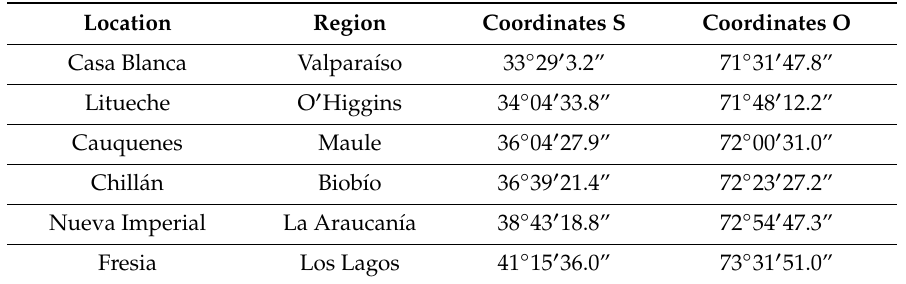
Table 1. Location of Eucalyptus globulus plantations where Ophelimus nov. Sp. samples were collected.